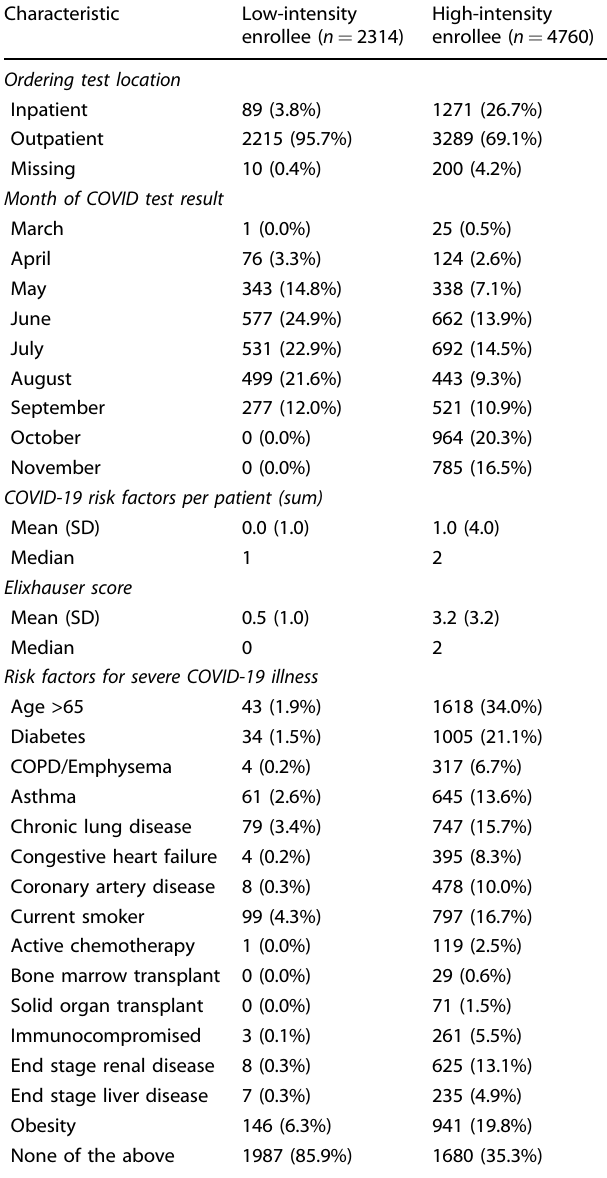
Table 3. COVID-19 related characteristics and risk factors for severe